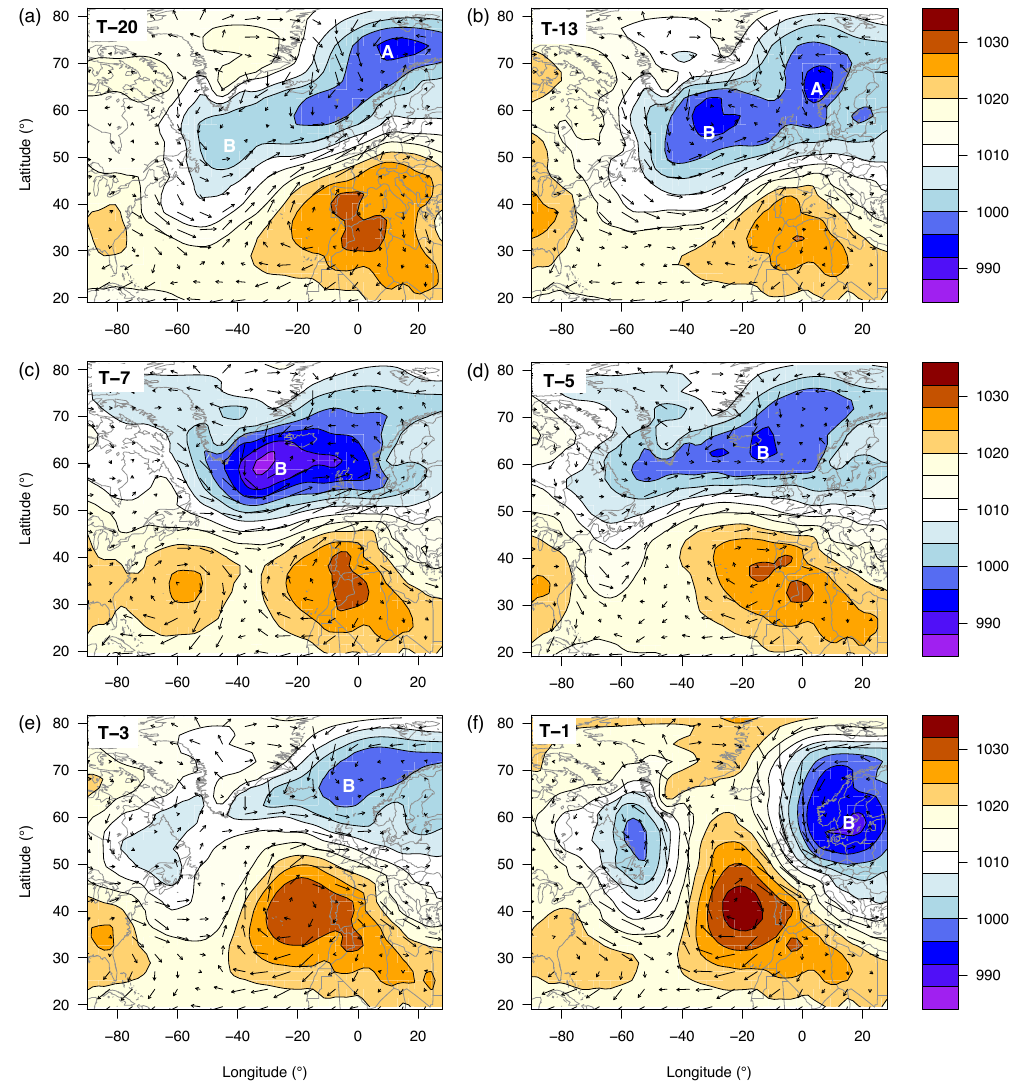
Fig. 8. Evolution of the SLP composite satisfying the joint extreme conditions ( n = 20 for precipitation) at times T (15 events). Time references are in days relative to T